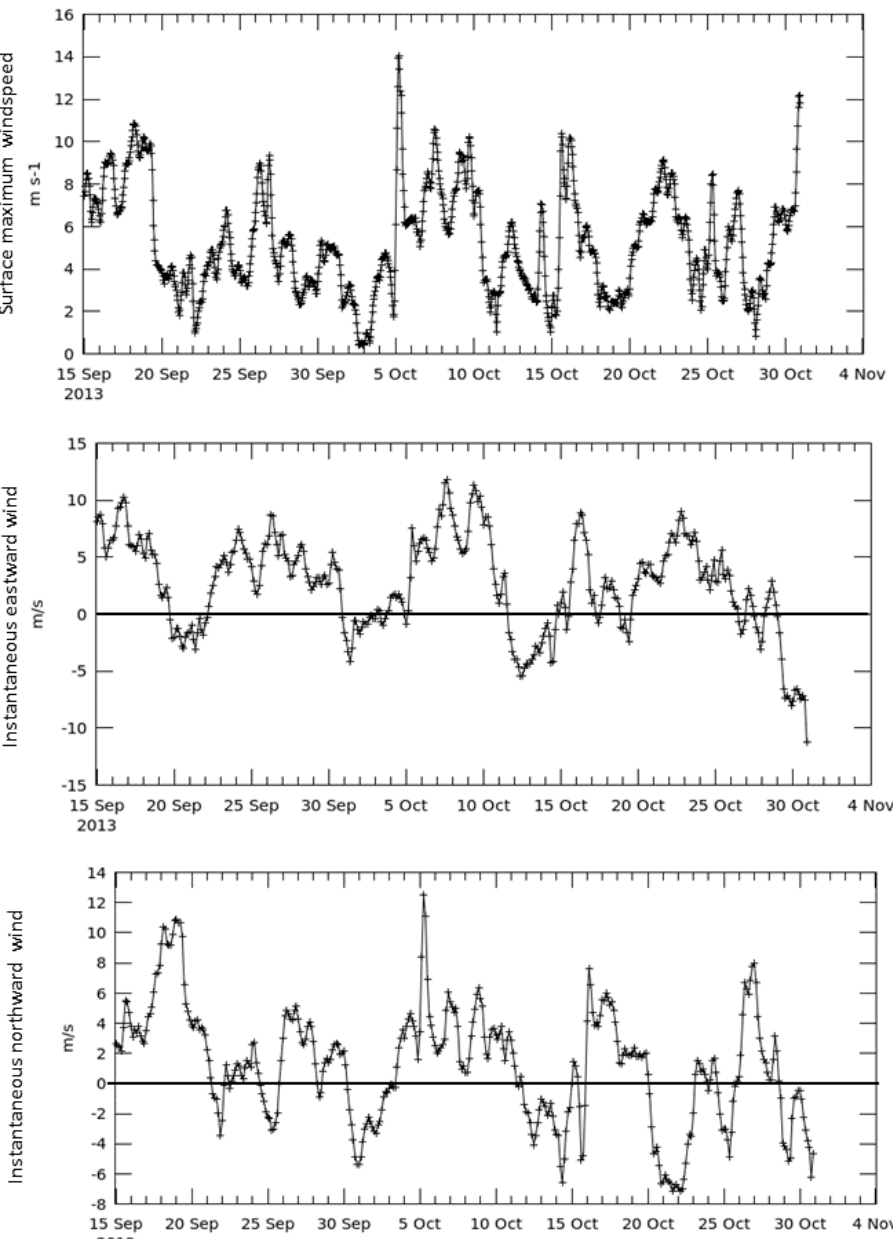
Figure 8. ( top ) MERRA-2 surface maximum windspeed ( center ) instantaneous eastward wind and ( bottom ) instantaneous northward wind for the Chuuk Lagoon region. The eastward and northward wind data are for the 950 hPA pressure layer. The time period is 15 September 2013 to 30 October 2013. The boundaries of the region used for this plot are 151.0 – 152.5 E, 6.7 – 8.2 N.